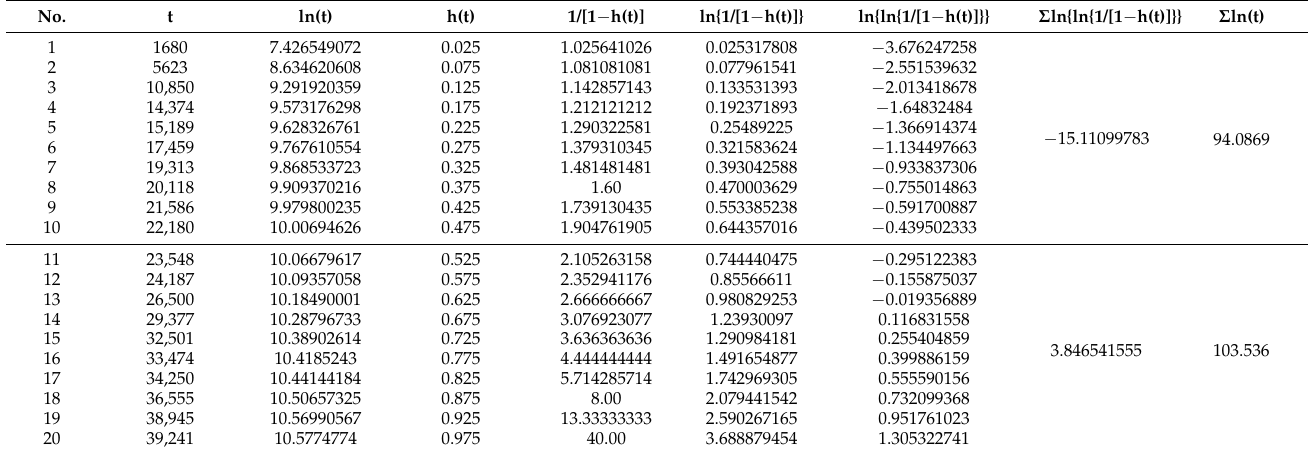
Table 7. CHP plant performance data for 2016–2020.